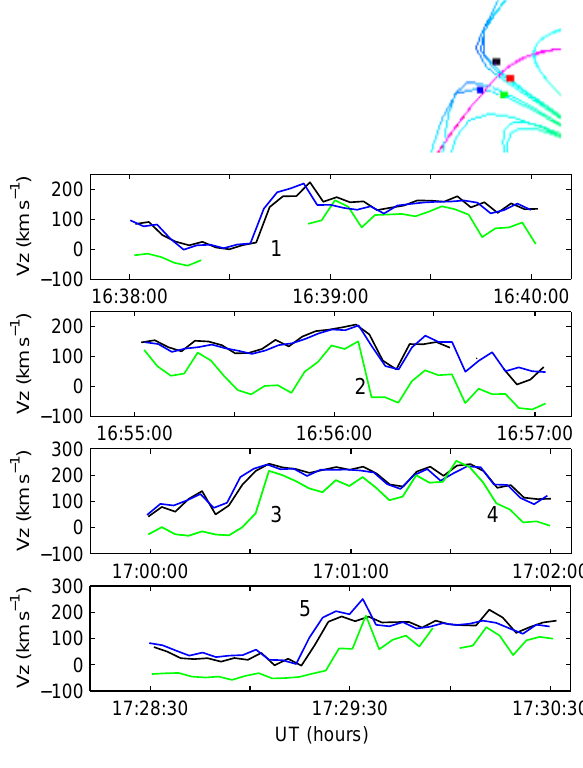
Fig. 10. Crossing of the inward boundaries (1, 3 and 5) of the anti-sunward ion flow velocity in sequence by SC4 (blue), SC1 (black) and SC3 (green), and crossing of the outward boundaries (2 and 4) in the reverse sequence by SC3, SC1 and SC4. Two min- utes of V z data from CIS centred around 16:39:00 UT (crossing 1), 16:56:00 UT (crossing 2), 17:01:00 UT (crossings 3 and 4) and 17:29:30 UT (crossing 5) are shown; no data from CIS in SC2. The outward boundary (6) of the last event is not shown for being com- paratively slow. The picture in the right top shows the spacecraft configuration (expanded many times) in the